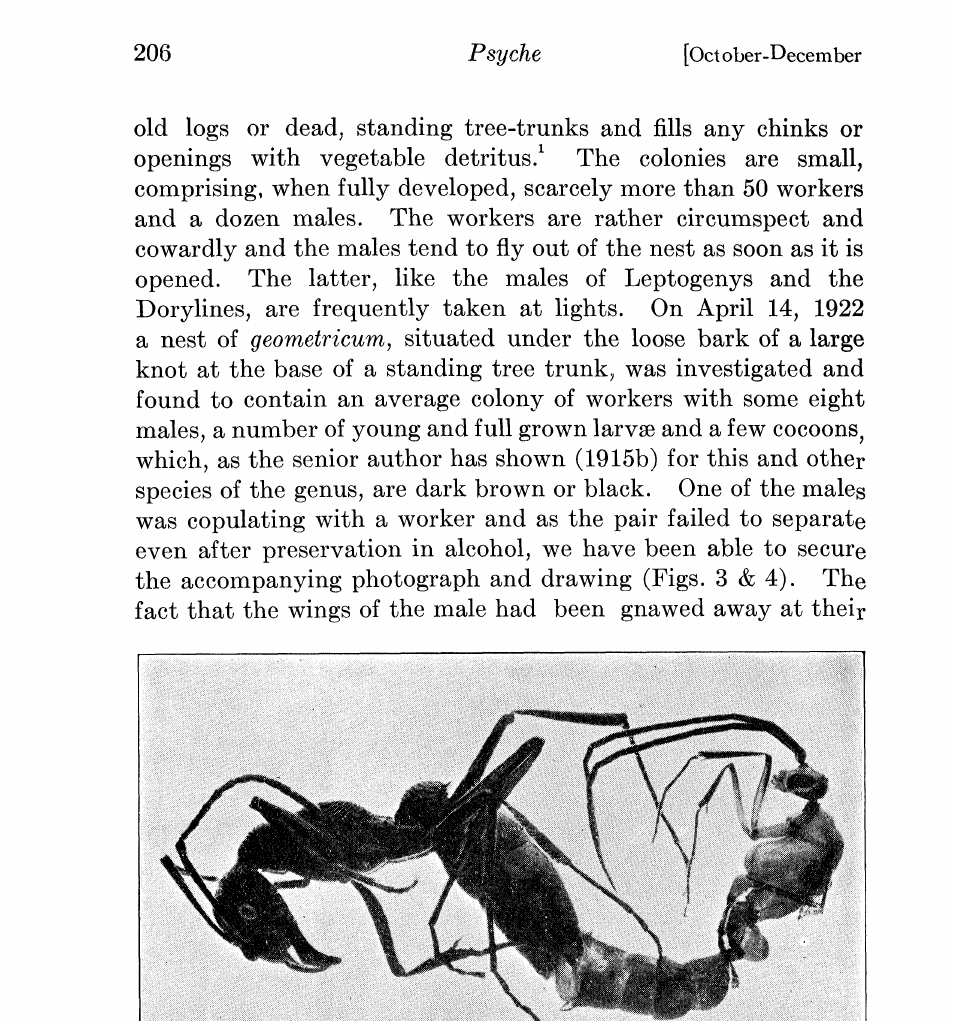
Fig. 3. Fertile worker and male of Diacamma rugosum geometricum in copula, from the left side